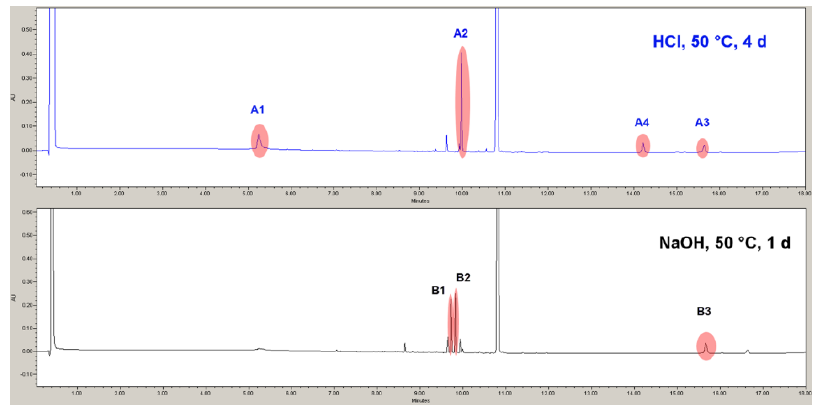
Figure 4. Chromatograms of venetoclax stress samples with added HCl (top) or NaOH (bottom) where 10–20% of total degradation occurred. Selected potential primary degradation products are marked with red ovals and labelled A1–A4 for acid degradation products and B1–B3 for base degradation products. For chromatographic conditions, see Section 2.3. UHPLC Method Conditions.